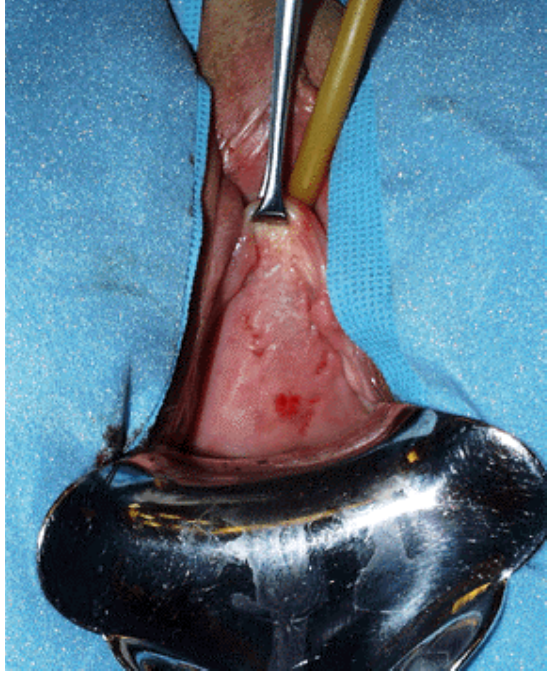
FIGURE 1. Allis clamps are placed under the urethral meatus to provide upward traction on the anterior vaginal wall.